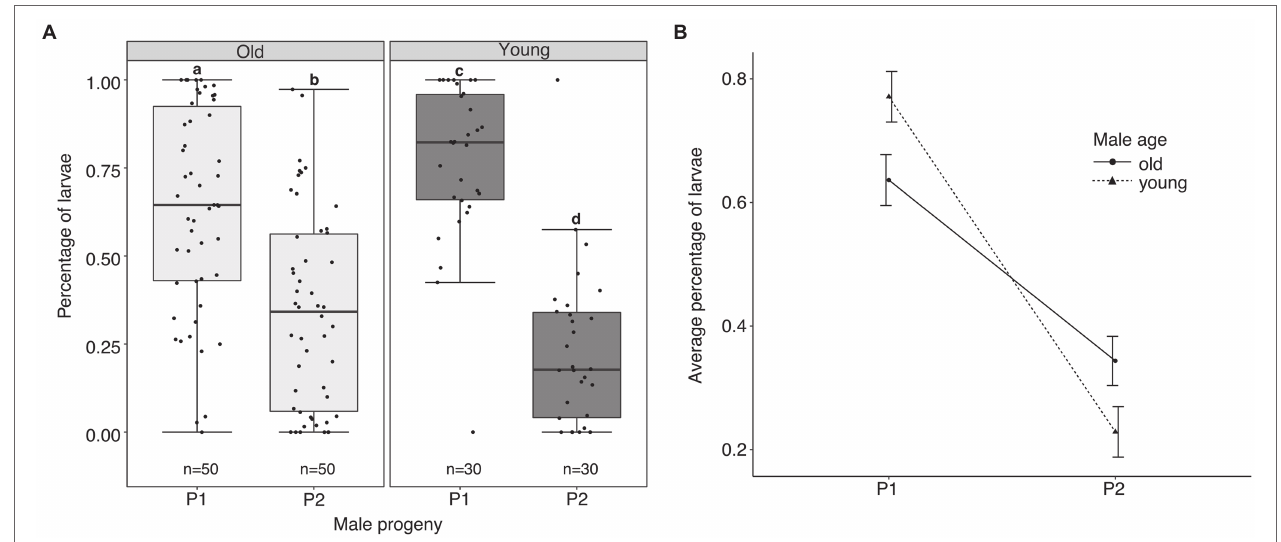
FIGURE 2 | Sperm use patterns in multiply mated A. aegypti females. (A) The proportion of progeny sired by the first (P1) and second (P2) mating male for each age group. The middle horizontal line in the box plots represents the median, the lower and upper margins of the box represent the 25th and 75th quartiles, and the whiskers extend to the minimum and maximum of the data (excluding outliers, shown as points outside the whiskers). Different letters above each box plot represent significant differences ( p < 0.05) for a Tukey test. (B) Mean (±SE) P1 and P2 scores in females initially mated to an old or young male.